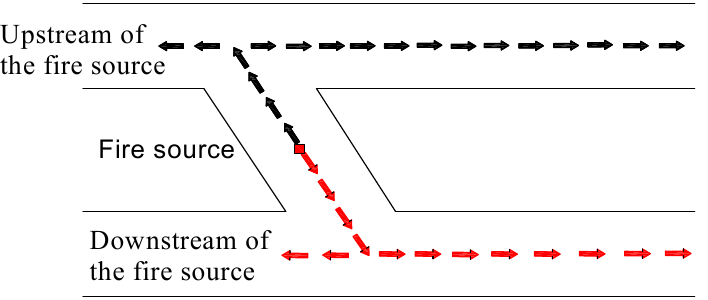
Figure 7. Diagram of temperature attenuation route. From (c) and (d), it can be seen that when the wind speed is 3 m/s and 4 m/s, the high- temperature smoke moves in the direction of wind flow after coming out of the diagonal branch, and the high-temperature area in the left and right channel is downstream of the correlation point. The high-temperature range is more extensive than that of 1 m/s and 2 m/s. In addition to the high-temperature range, the overall heating area is also longer, and the heating area of the left and right paths is close to the return air